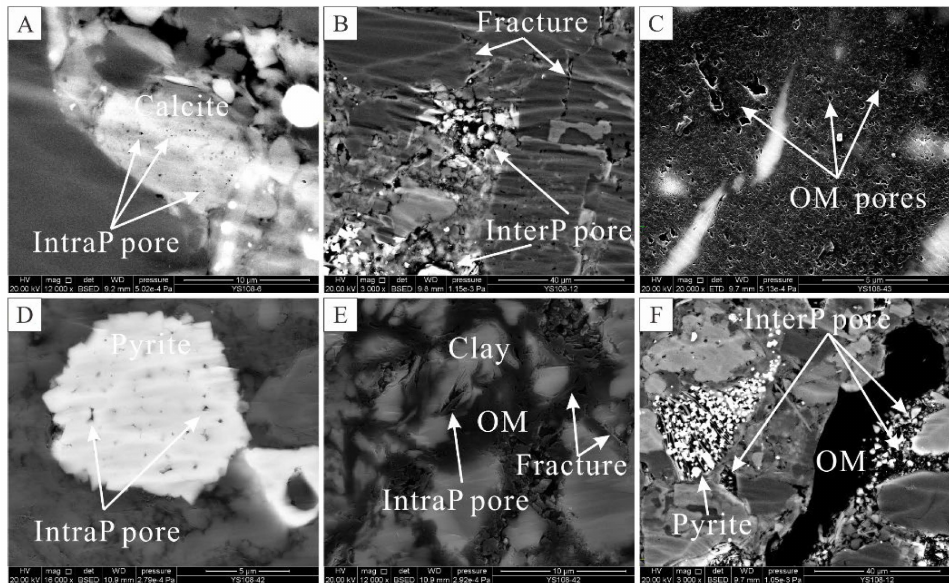
Figure 4. FE-SEM images of Wufeng-Longmaxi Fm shale within typical pore types. ( A ) Intraparti- cle pore of calcite; ( B ) Mineral grains interparticle pores and fracture; ( C ) Organic matter pores; ( D ) Intraparticle pore of pyrite; ( E ) Clay minerals interparticle pore and fracture; ( F ) Brittle mineral interparticle pore. OM—Organic